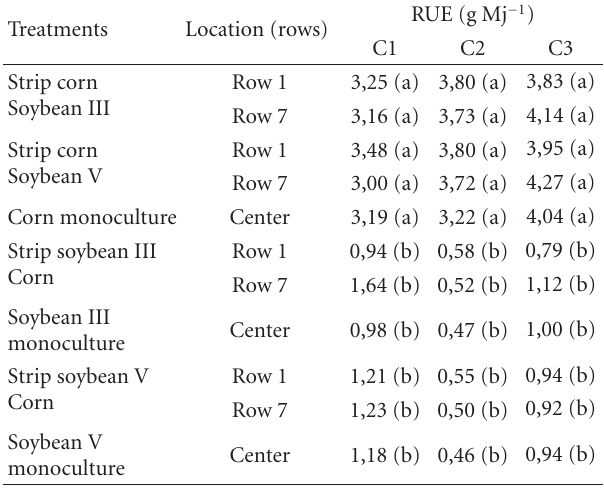
Table 2: RUE (g Mj − 1 ) in monocultures and intercropped, during C1, C2 and